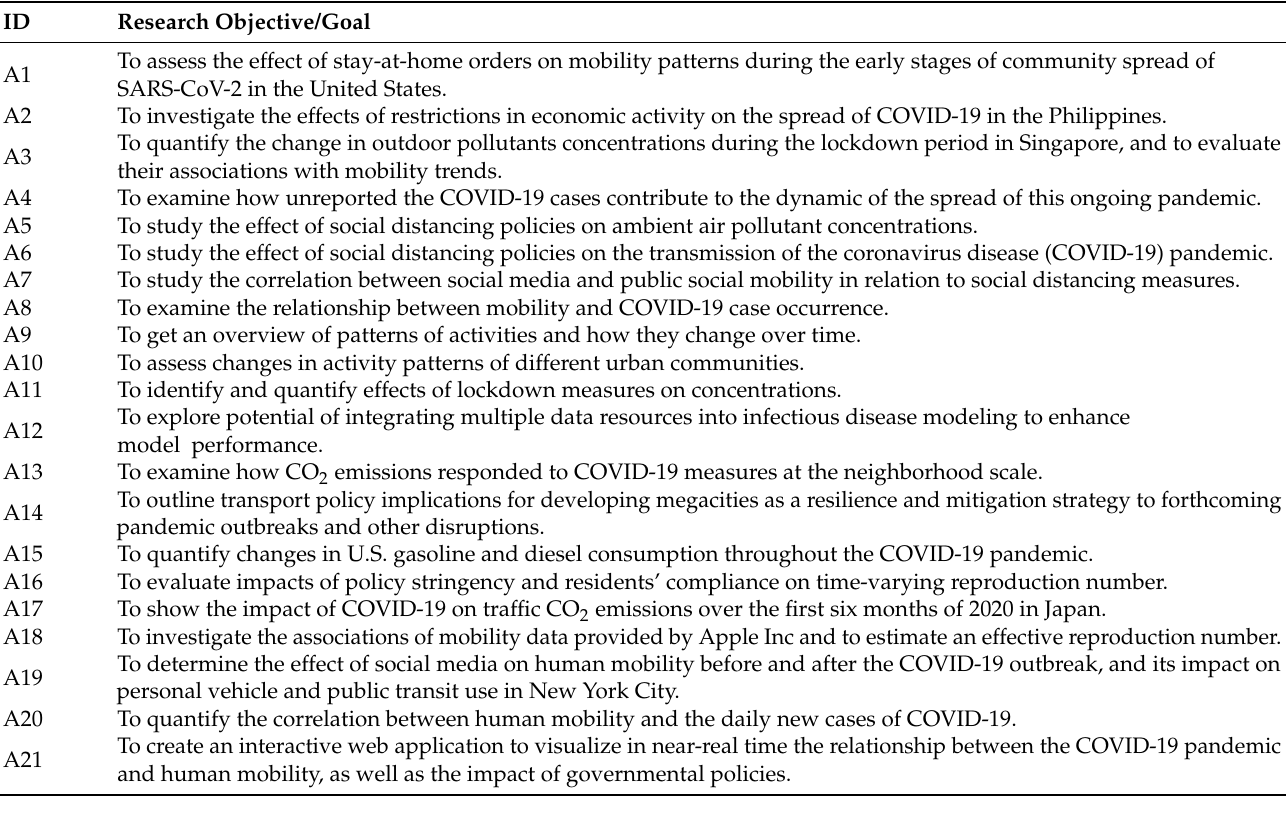
Table 2. Main objectives and goals set in each of the reviewed